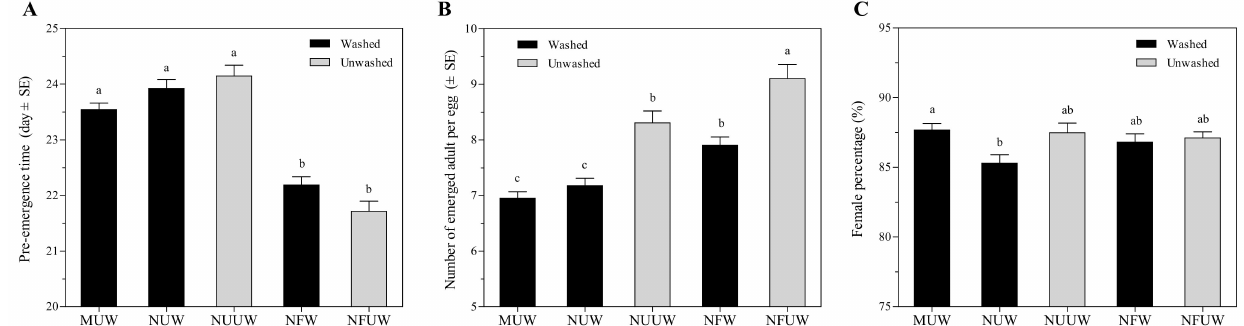
Figure 2. Pre-emergence time ( A ), the number of emerged adults per egg ( B ), and female progeny percentage ( C ) of Aprostocetus brevipedicellus on Antheraea pernyi eggs with the five treatments. MUW: manually-extracted, unfertilized and washed eggs; NUW: naturally-laid, unfertilized and washed eggs; NUUW: naturally-laid, unfertilized and unwashed eggs; NFW: naturally-laid, fertilized and washed eggs; NFUW: naturally-laid, fertilized and unwashed eggs. Different lower-case letters on bars indicate significant differences among egg treatments based on Tukey’s multiple comparison (HSD) test ( p < 0.05).